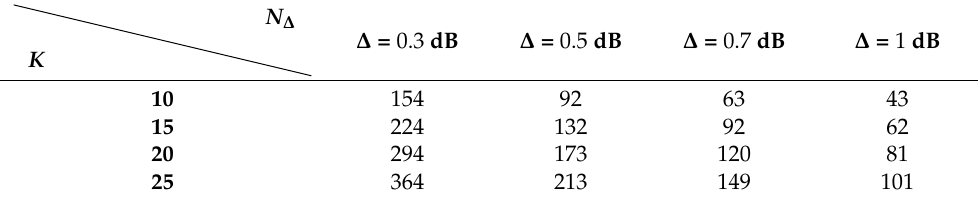
Table 2. Number of intensity accumulation for different K and ∆